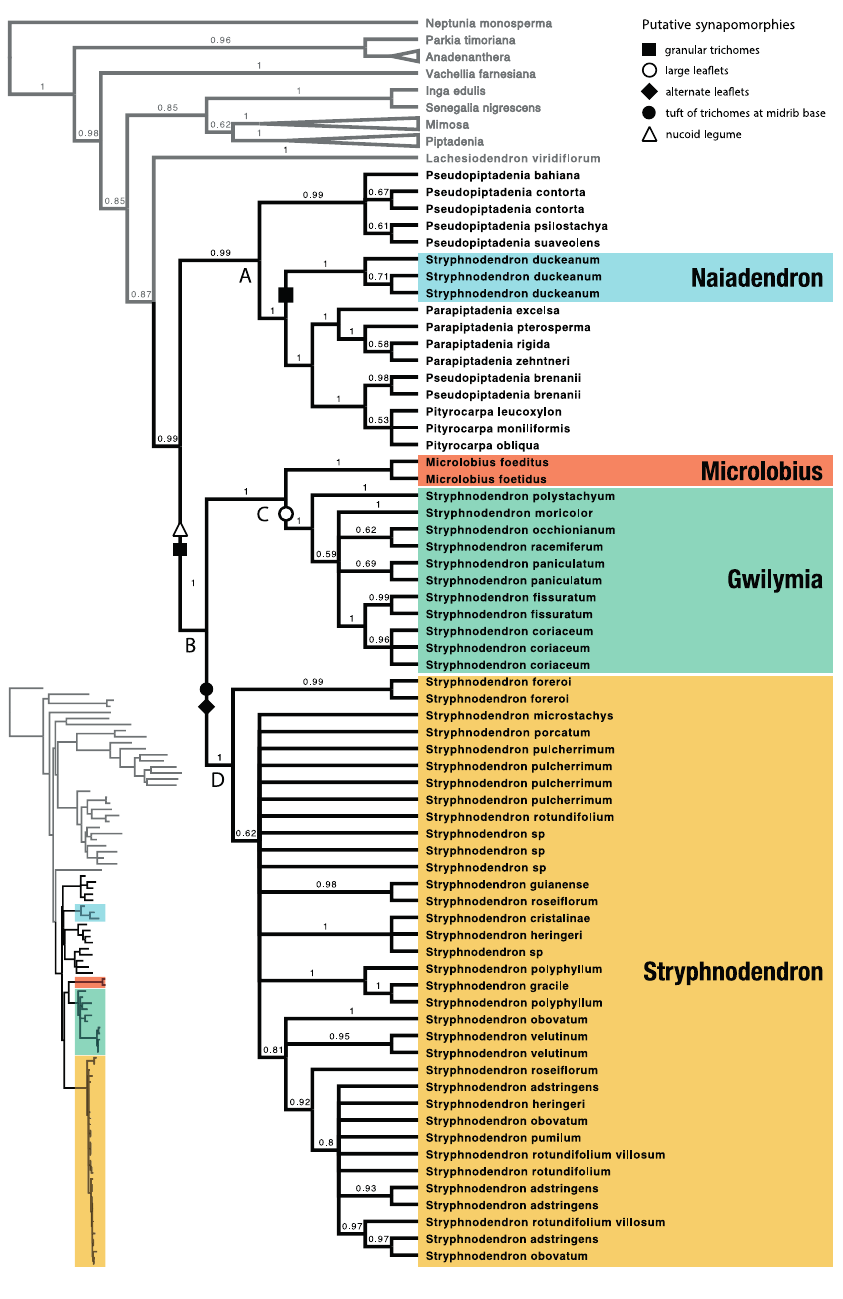
Figure 2. Relationships in the Stryphnodendron clade based on ( matK/trnK , trnD-trnT , trnL-trnF ) and nuclear (ITS) DNA data; constrained by a phylogenomic backbone. 50% majority-rule consensus tree and posterior probability values (above branches) from trees sampled in the posterior Bayesian analysis. Symbols indicate selected putative morphological synapomorphies. The inset tree depicts the Bayesian phylogram with inferred branch